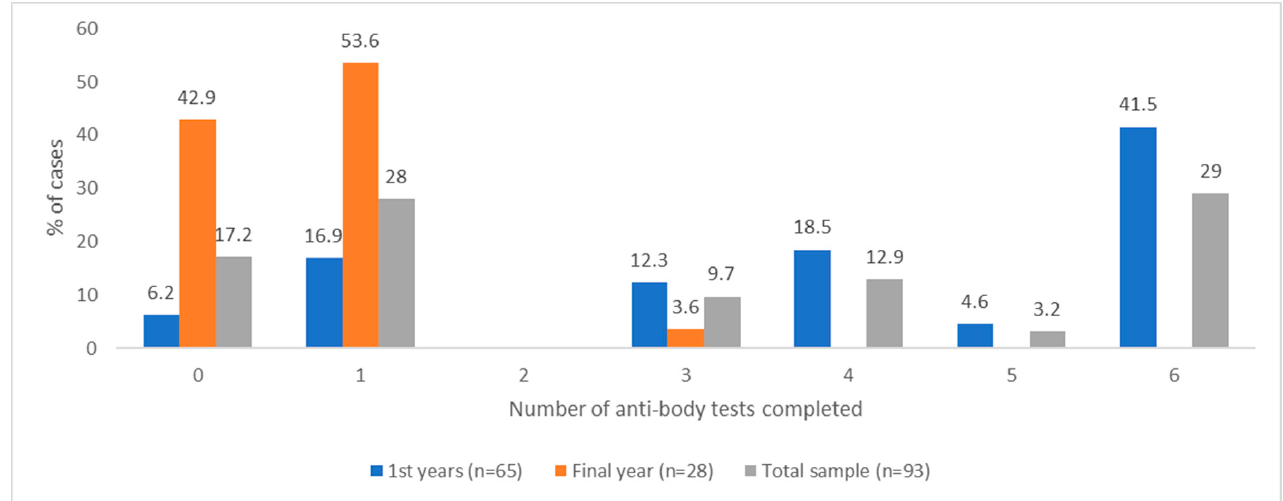
ATS by total sample and stratified by first and final years. by total sample and stratified by first and final years.